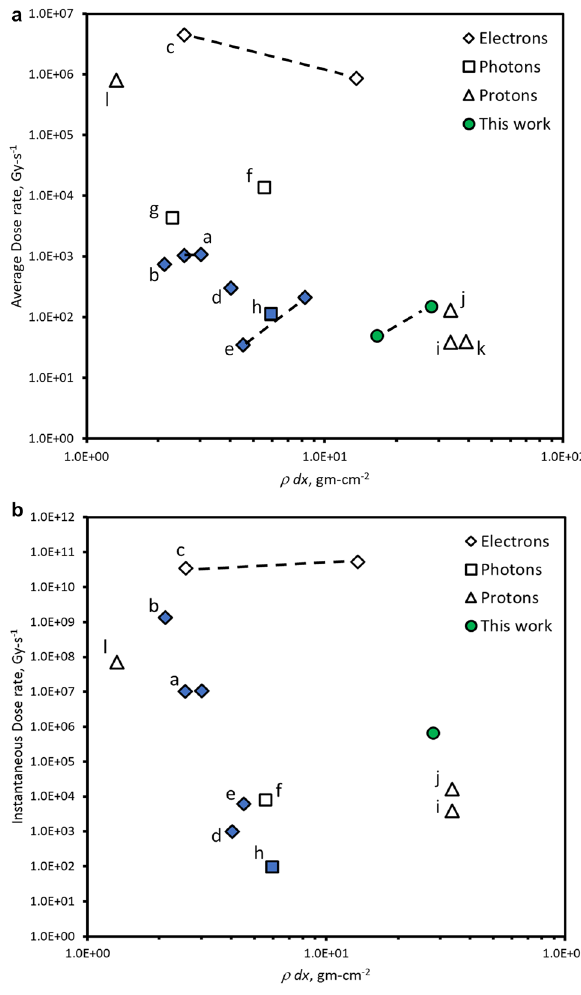
Figure 2. ( a ) A system survey of FLASH-RT average dose rate and ( b ) instantaneous dose rate as a function of range calculated from details obtained from the literature. See Table 1 for specific details. Solid blue markers designate clinic scale systems that can be placed in an approximately 100 m 3 radiation vault. Dotted